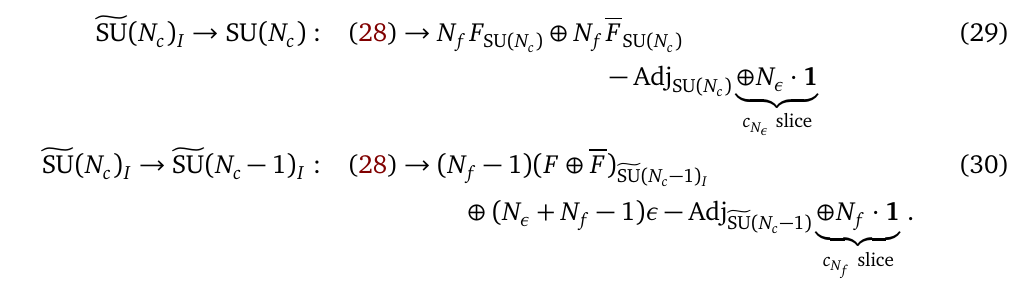
Figure 2: Higgs branch Hasse diagram of (cid:221) SU ( 4 ) leaf, we write its dimension (in green) and the quiver of the effective